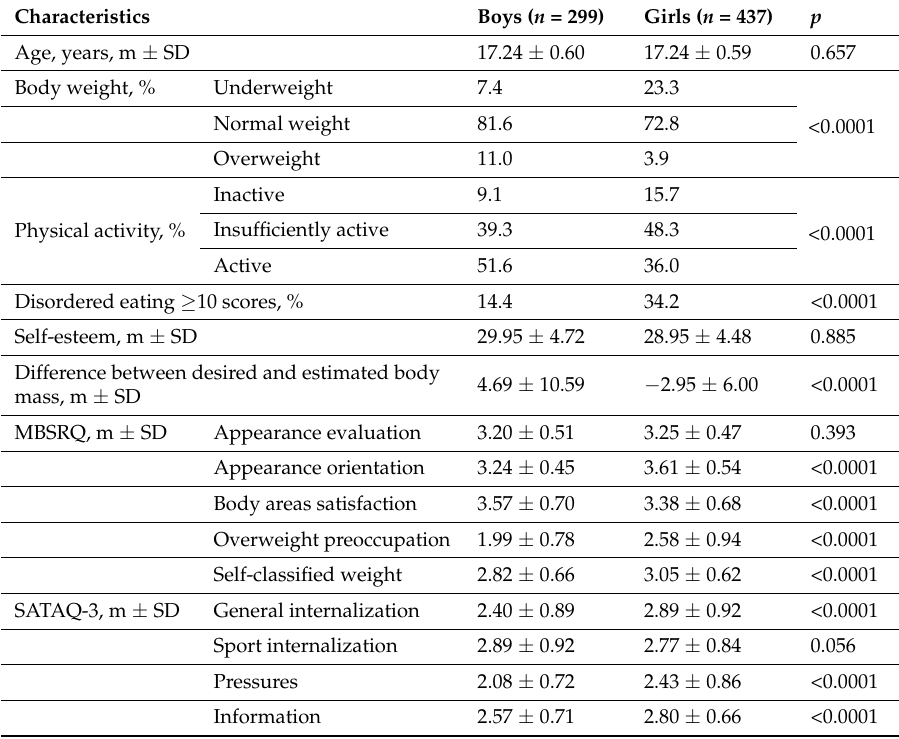
Table 1. Descriptive characteristics of the